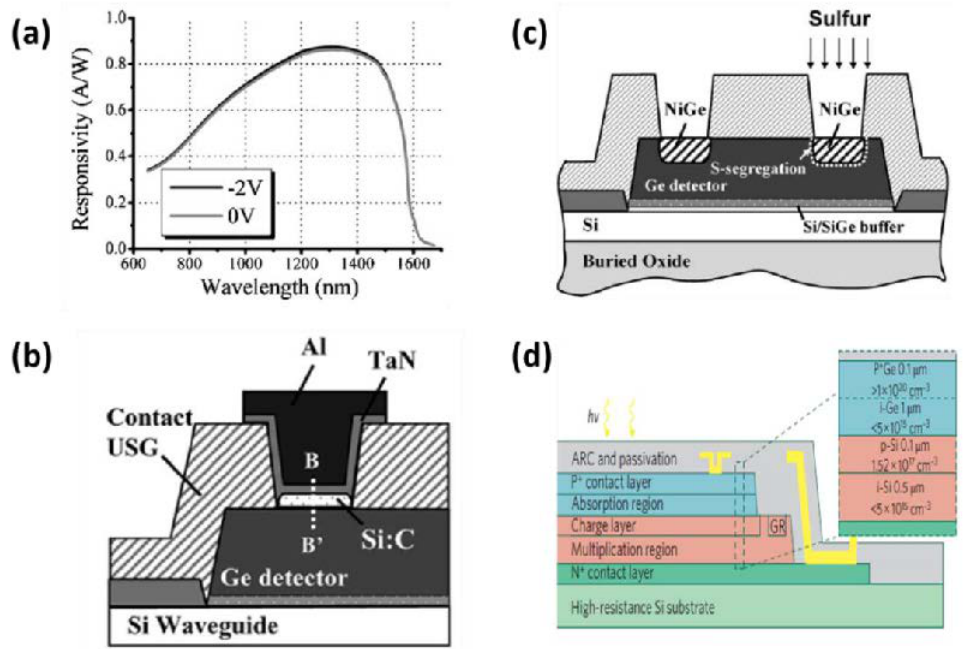
Figure 4: (a) Responsivity of Ge p-i-n PD at 0 V and 2 V reverse bias in wavelength range of 650 – 1650 nm. The whole C band and a large part of L band is covered even at 0 V. (b) Schematics of the Ge MSM PD with a Si:C layer to enhance the Schottky barrier. (c) Schematics of the Ge MSM PD implanted with segregating sulfur dopant. (d) A 340 GHz gain-bandwidth Ge APD. Figure with reprint permission from: (a) Ref. [77] ©2005 American Institute of Physics, (b) Ref. [88] ©2008 IEEE, (c) Ref. [91] ©2008 IEEE, and (d) Ref. [19] ©2009 Macmillan Publishers Limited.